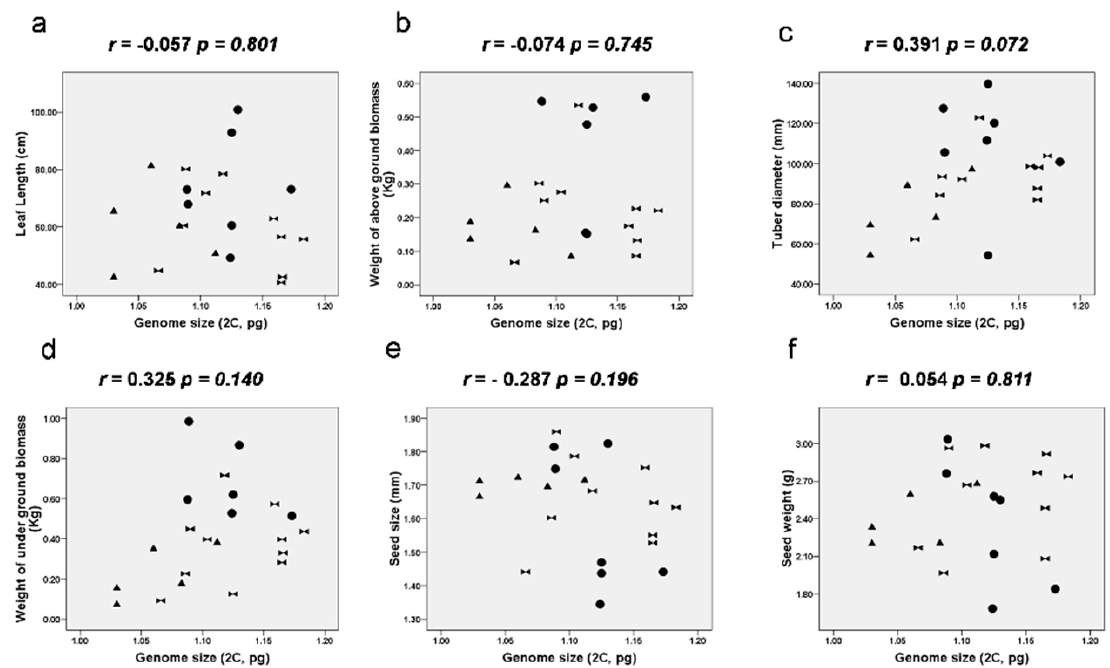
Figure 4. Correlation of genome size with morphological and reproductive characters showing genome size isunaffected by morphological traits. The scatter plot are showing correlation of ( a ) genome size-leaf length, ( b ) genome size–above-ground biomass, ( c ) genome size–tuber diameter, ( d ) genome size–weight of below-ground biomass, ( e ) genome size-seed size, ( f ) genome size-seed weight. The filled circles represent landraces from Hengduanshan, filled triangles represent landraces from Qinghai Tibetan Plateau, and the filled dumbbellshapes represent landraces from the Himalayas.